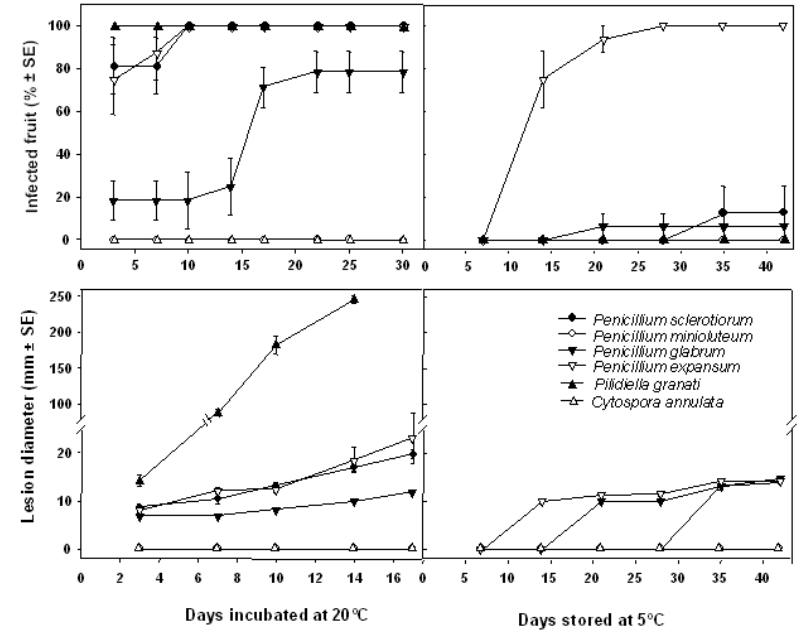
Figure 6. Pathogenicity and disease development tests. Percentage of infected fruit and lesion size on pomegranates cv. Mollar de Elche artificially inoculated with fungi isolated from naturally infected fruit. The inoculated fruits were incu - bated at 20ºC for up to 30 d or stored at 5ºC for up to 42 d. Data are means from two